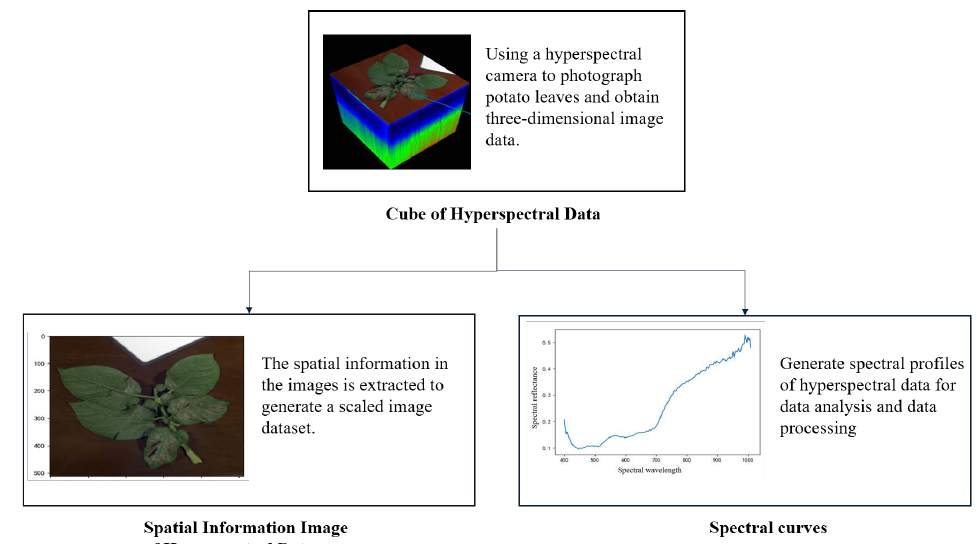
Figure 1. Hyperspectral image of potato diseased leaves.